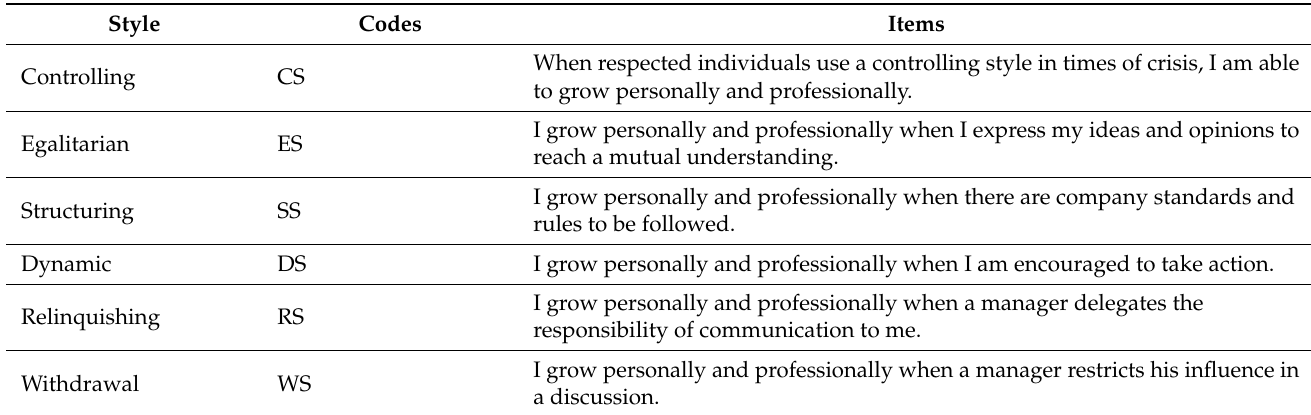
Table 3. Item indexing the effect of interpersonal communication style on personal and professional growth (adapted from